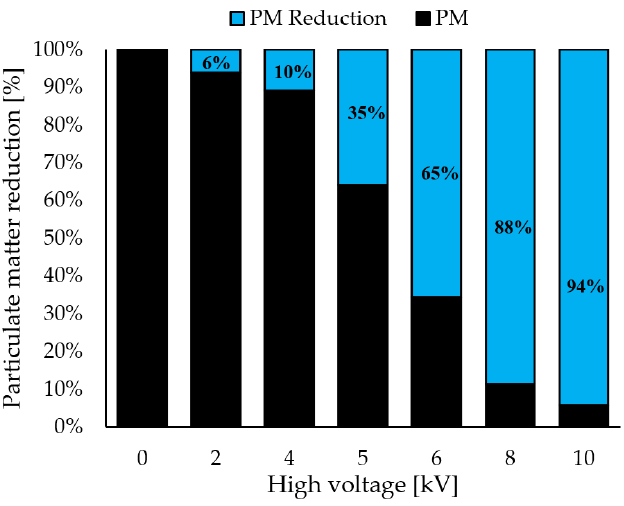
Figure 6. The reduction of Particle number without Porous Material and NTP.